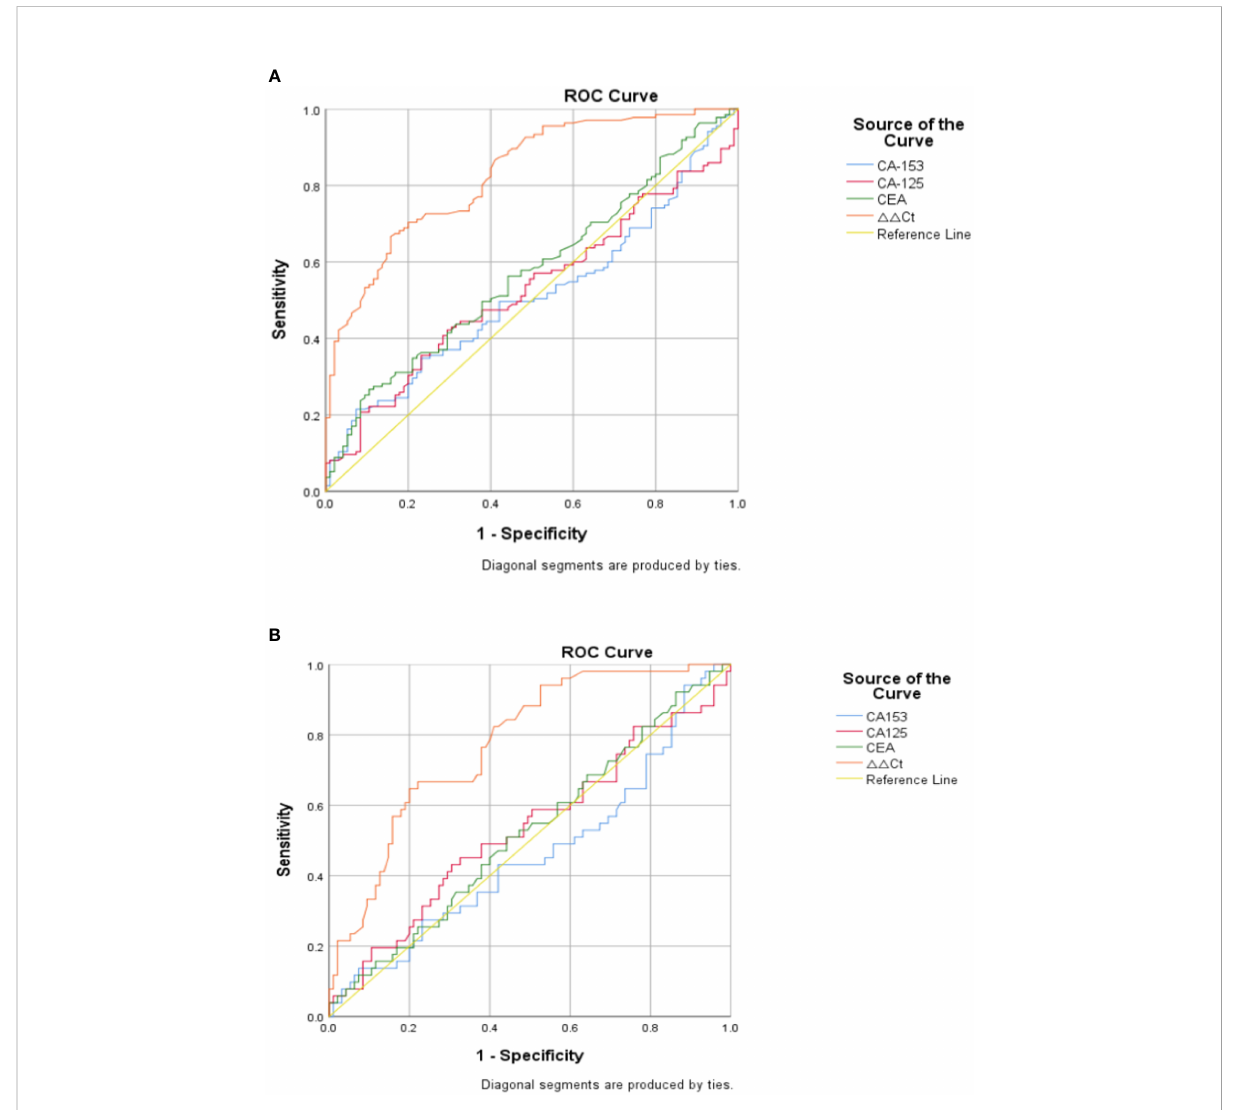
FIGURE 3 Diagnostic value of hsa_circ_0058514 for BC was evaluated by ROC curve. (A) In BC patients without metastasis. (B) In early BC patients (stages 0 and